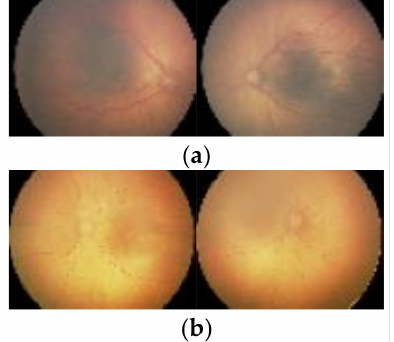
Figure 1. Samples of images included in the dataset, ( a ) Diseased, ( b ) Not